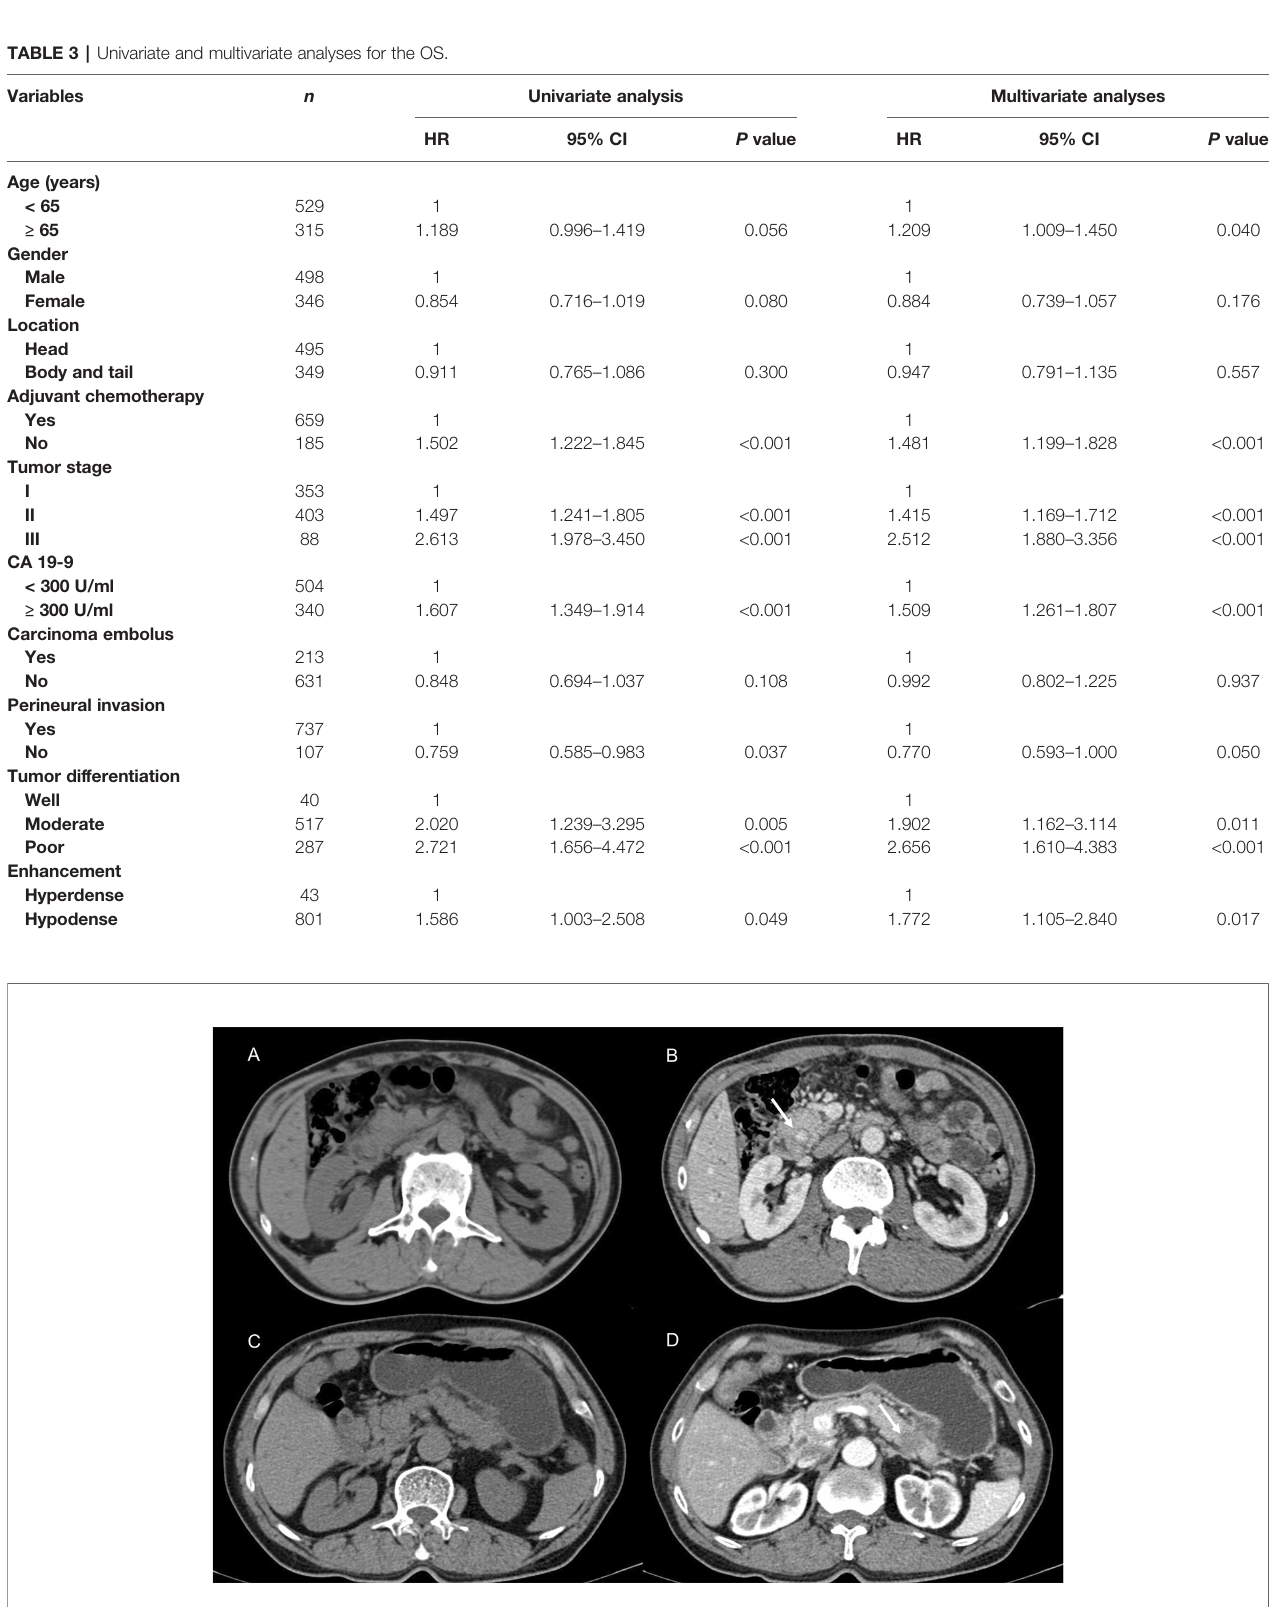
Frontiers in Oncology |